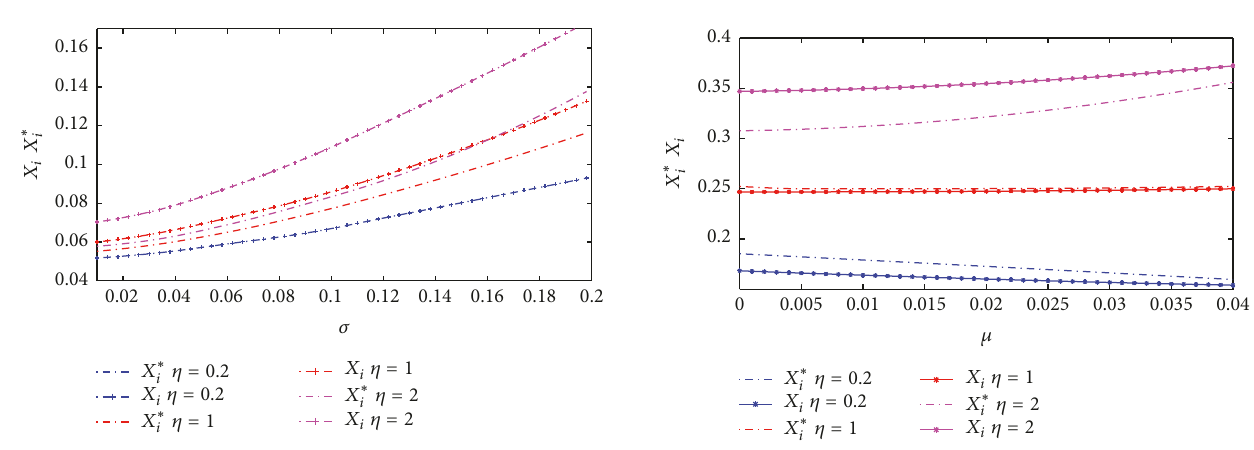
Figure 4: Investment triggers change with volatility. Figure 5: Relationships between expected growth rate and invest- ment